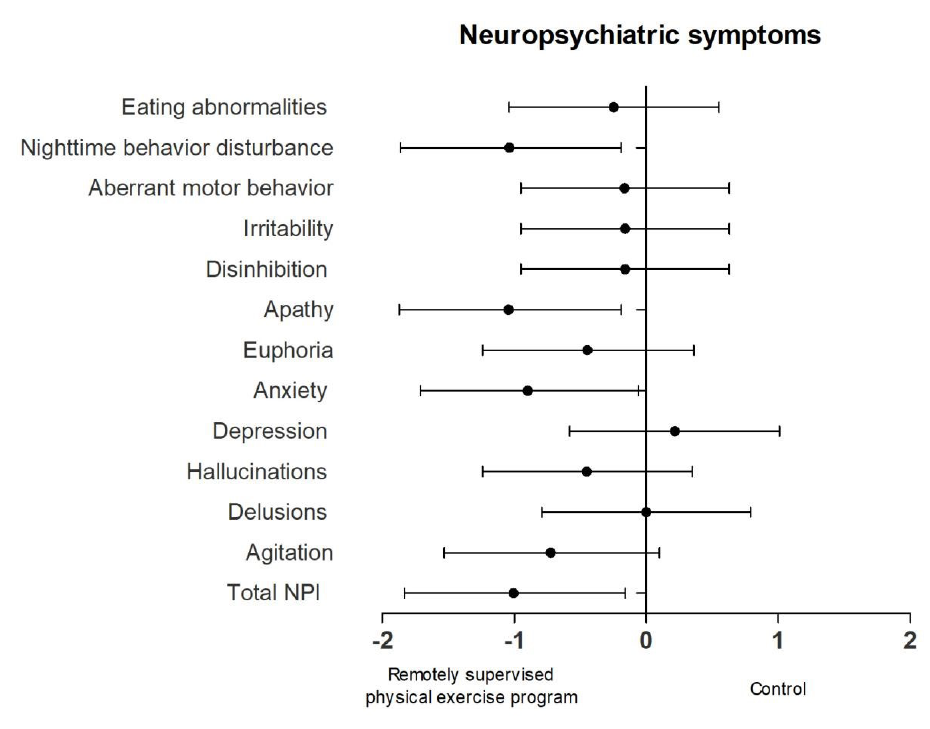
Figure 1. Effect sizes of neuropsychiatric symptoms by